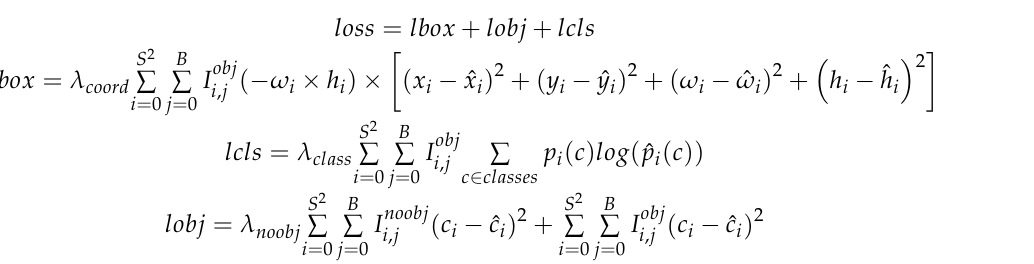
Figure 7. Structure of YOLOv5 deep object detection network.